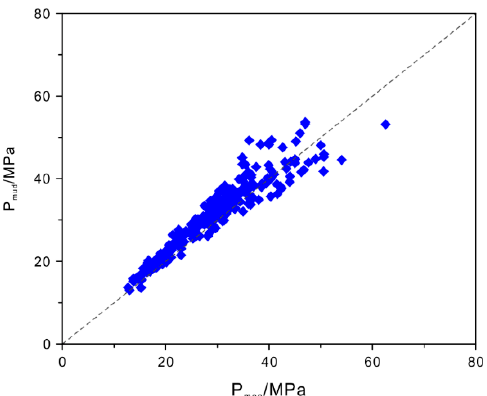
Figure 4. Comparison of the measured pressures and mud weight equivalent pressures. P mea is the measured pressure, and P mud is the pressure calculated from the mud weight.